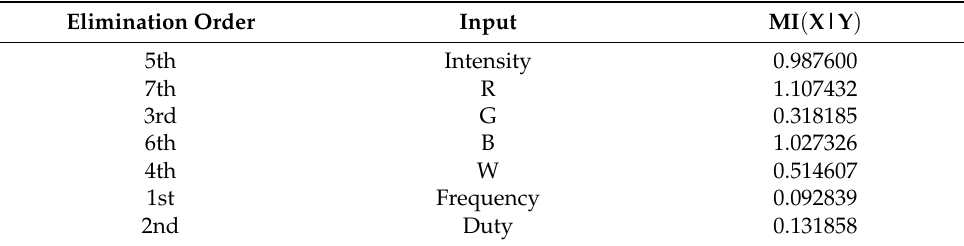
Table 5. Mutual information gain values for the energy consumption dataset.